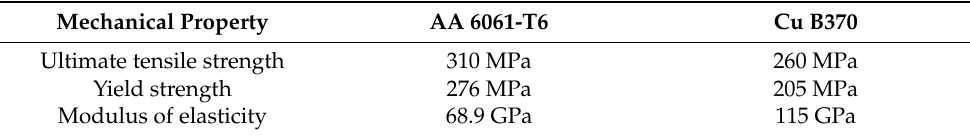
Table 2. Mechanical properties of AA 6061-T6 and Cu